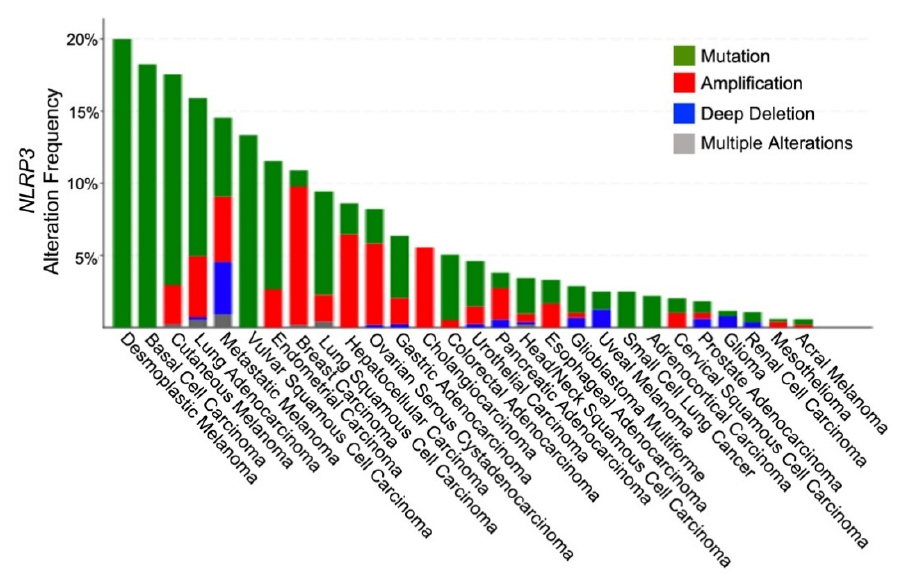
Figure 2. NLRP3 Genetic Alterations in Various Cancer Types. Figure adapted from cBioportal.com.